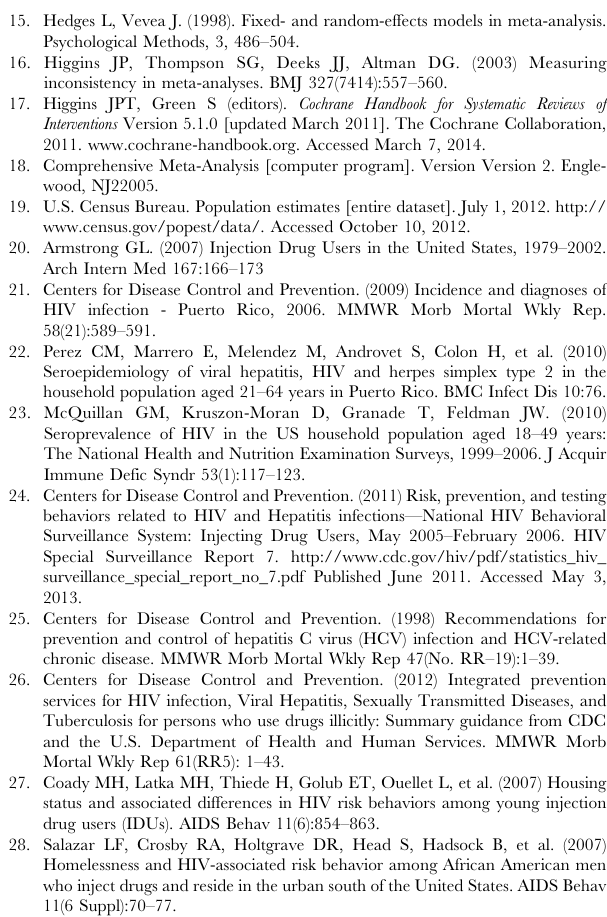
Table S3 Number, rate, and rate ratio of adult and adolescent persons who inject drugs (PWID) living with diagnosed HIV infection, by selected characteristics— United States,